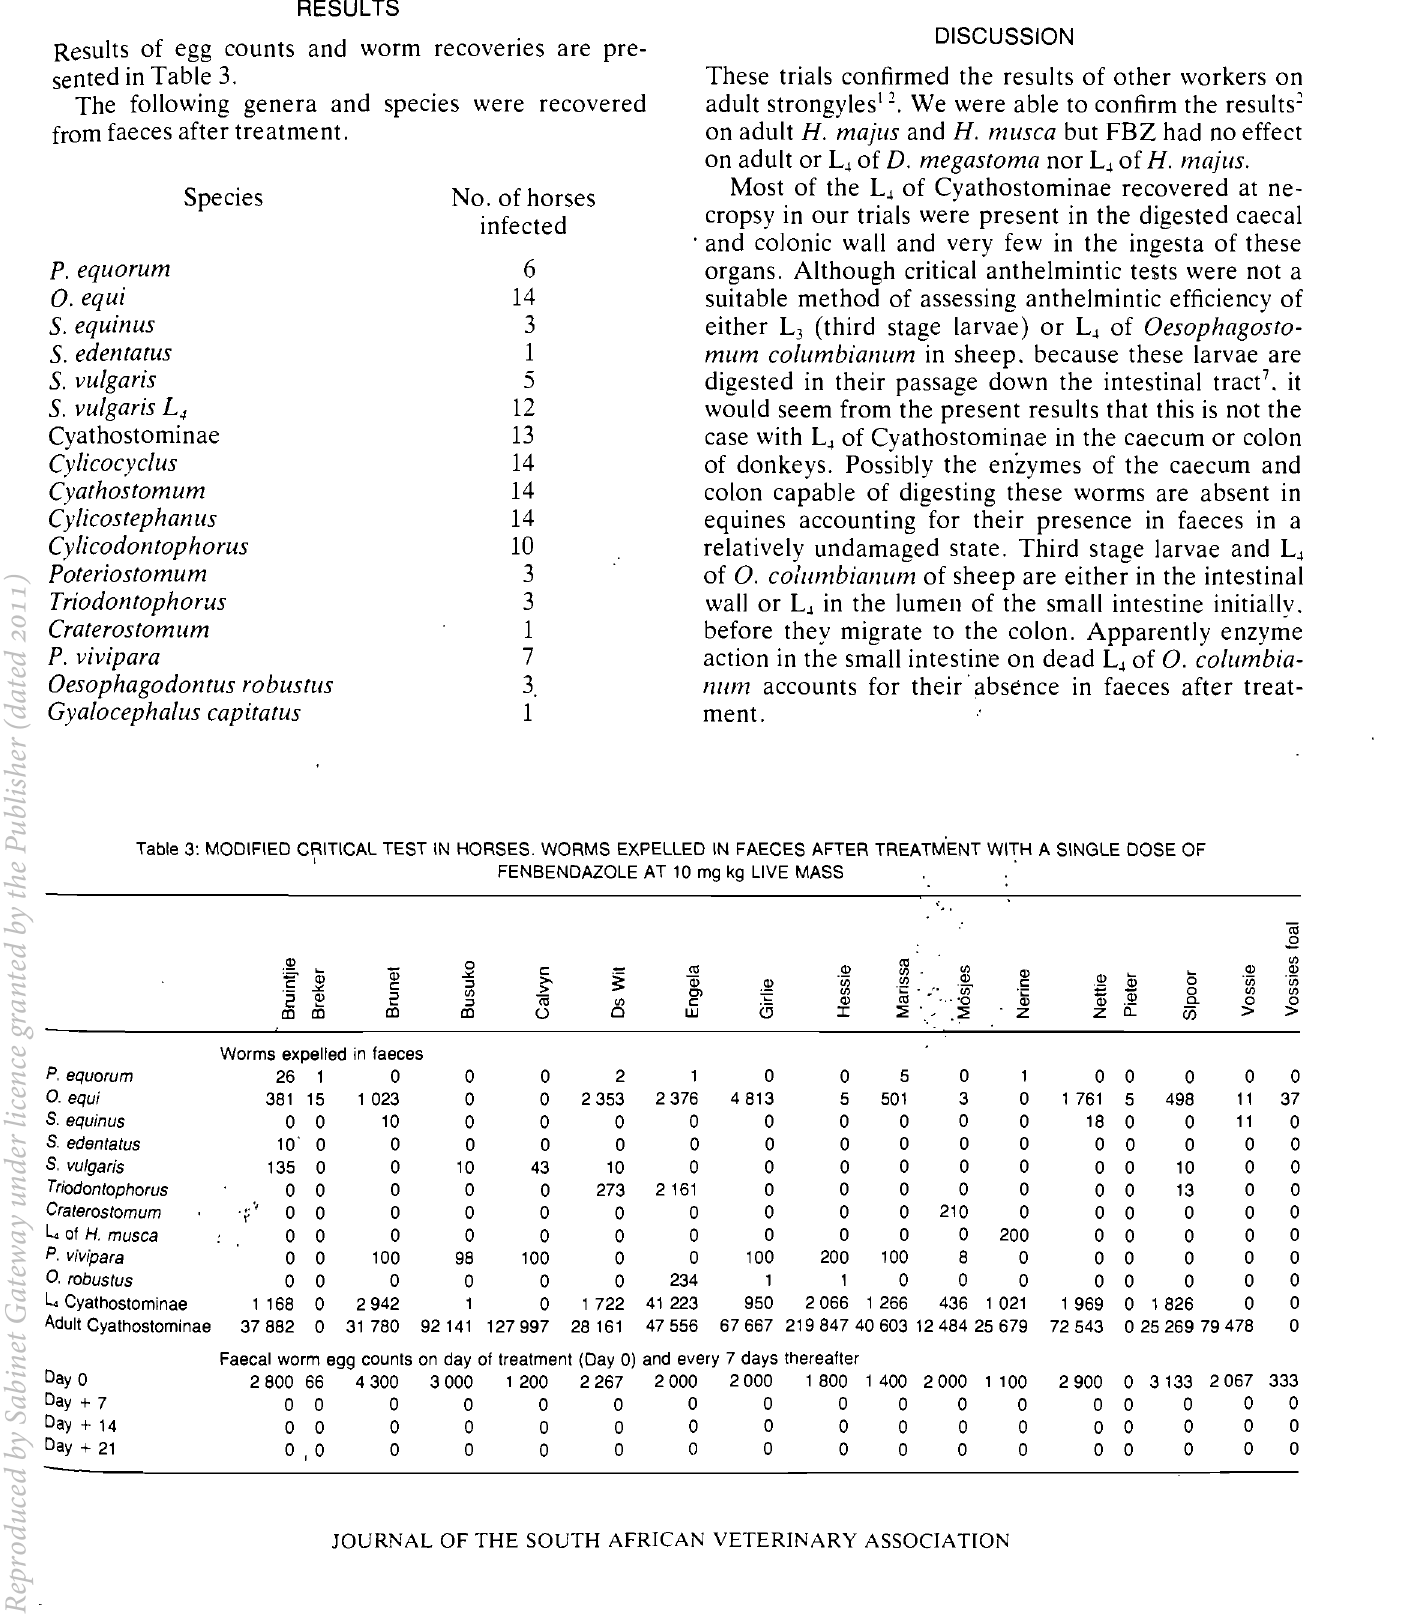
Table 3: MODIFIED CRITICAL TEST IN HORSES. WORMS EXPELLED IN FAECES AFTER TREATM'ENT WITH A SINGLE DOSE